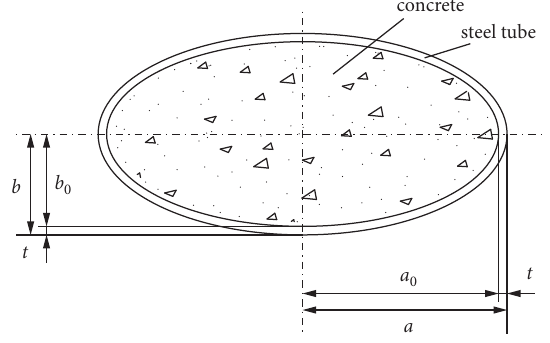
Figure 1: Cross-section of elliptical